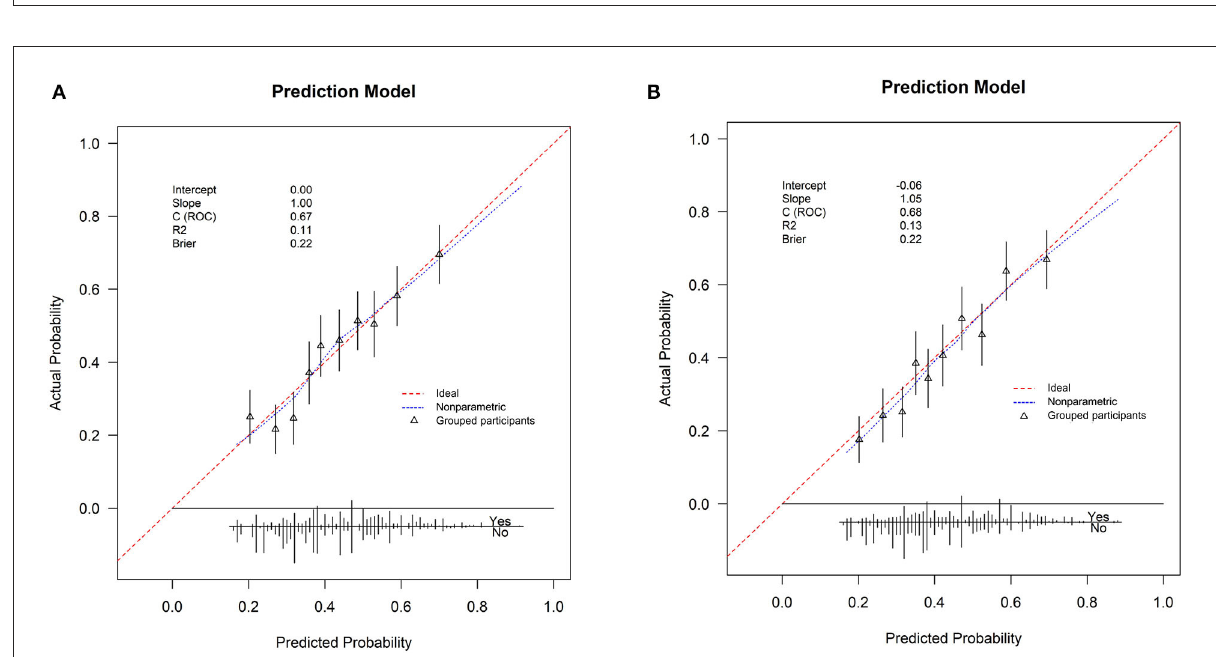
FIGURE7 Calibration curve for the nomogram in the two groups. (A) The training group; (B) the validation group. Calibration curve is plotted by predicted probability with observed probability. The red line indicates perfect consistency between predicted and observed probability, and the blue line indicates the calibrating line for the nomogram. The closer the blue line is to the red line, the better the calibration ability of the